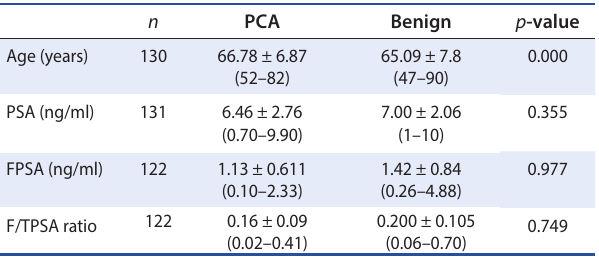
Note: In the benign lesion age category one patient was excluded as we did not have his age.